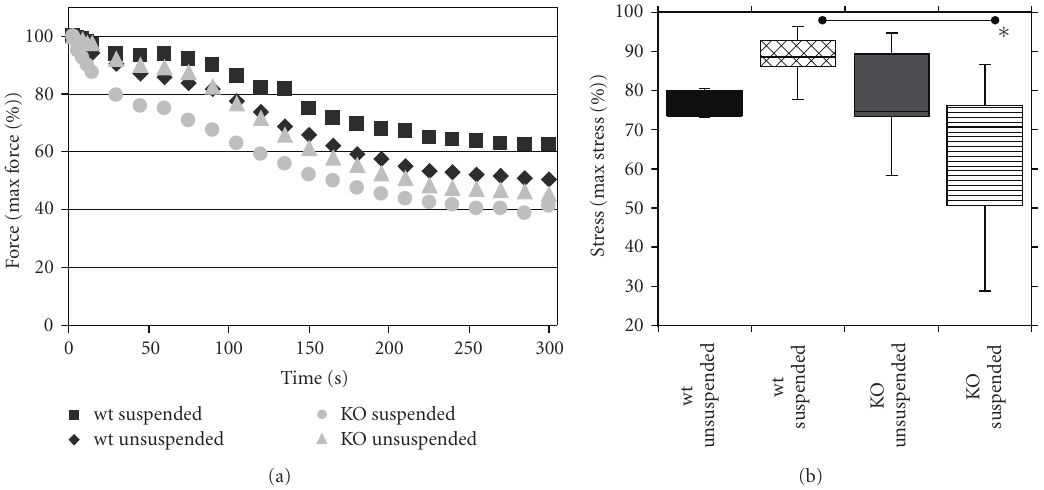
Figure 6: Muscle Fatigue. We fatigued the soleus muscle by stimulating the soleus muscle at a submaximal frequency (60Hz, inset of Figure 5(a)) every three seconds for a total of 100 stimuli. (a) The mean force of all muscles. (b) Force at the 105 second time point. There is a significant di ff erence between the wt suspended and the MuRF1-KO suspended